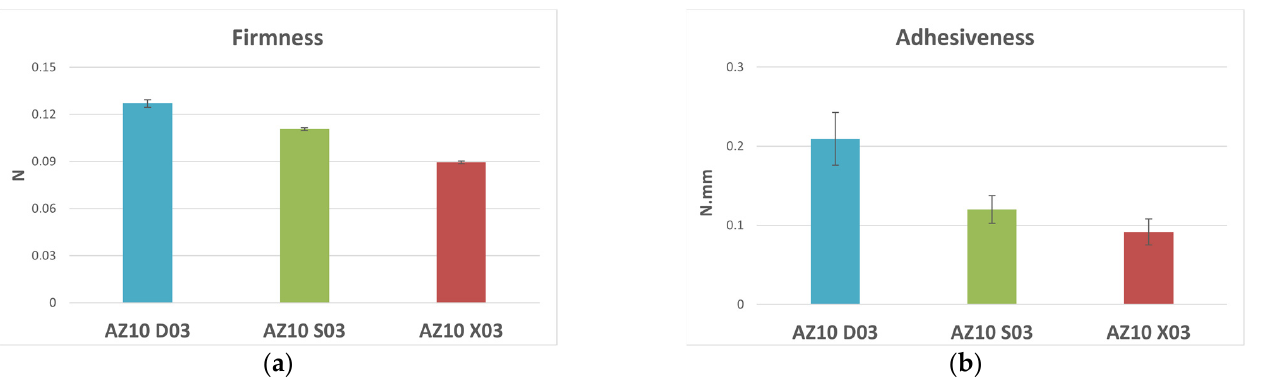
Figure 3. Textural parameters and standard deviations of firmness ( a ) and adhesiveness ( b ) measured by an immersion/de-immersion test for the emulsions prepared with A-Z associations (1:1) and the polysaccharides D, S, and X at 0.3% w/w.